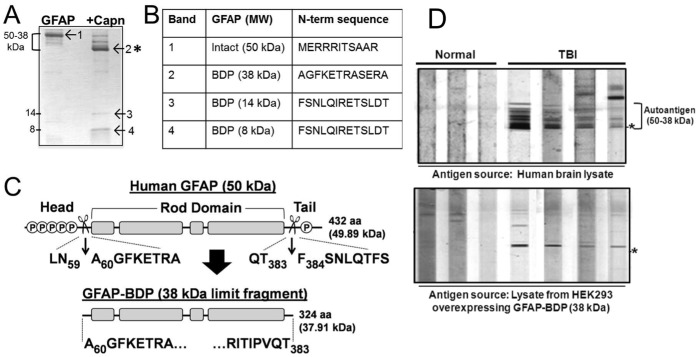
Calpain removed the termini of GFAP to generate the 38-BDP.
A. Human GFAP was undigested or digested with calpain (Capn), resolved on SDS-PAGE, stained with Coomassie blue R-250, and the indicated bands were excised. An asterisk marks the 38 kDa GFAP band. B. The N-terminal sequence of each band is shown in the table. C. Calpain cleavage sites (scissors) near the N- and C-termini of GFAP are shown in a schematic drawing of the GFAP. Subdomains (head, rod, tail) and identified/putative phosphorylation sites (P) are indicated, and the predicted 38 kDa calpain fragment is shown. D. Three control and four post-TBI human serum samples (Day 4–10) were probed against human brain lysate (top panel) and cell lysate from HEK cells overexpressing the 38 kDa GFAP-BDP (lower panel).